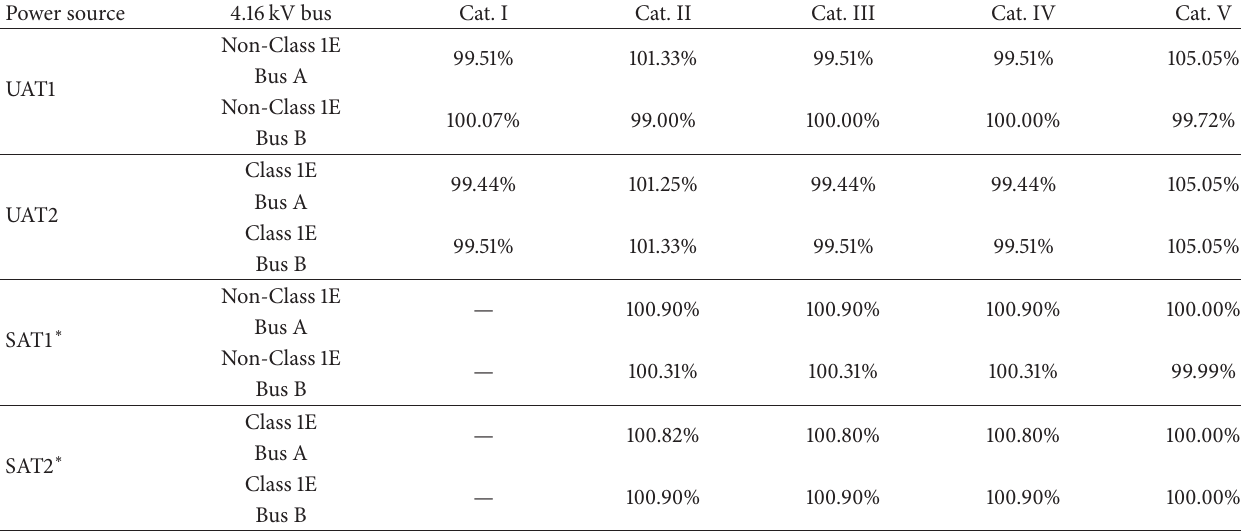
Table 6: The result of the modified electric power system load flow analysis.